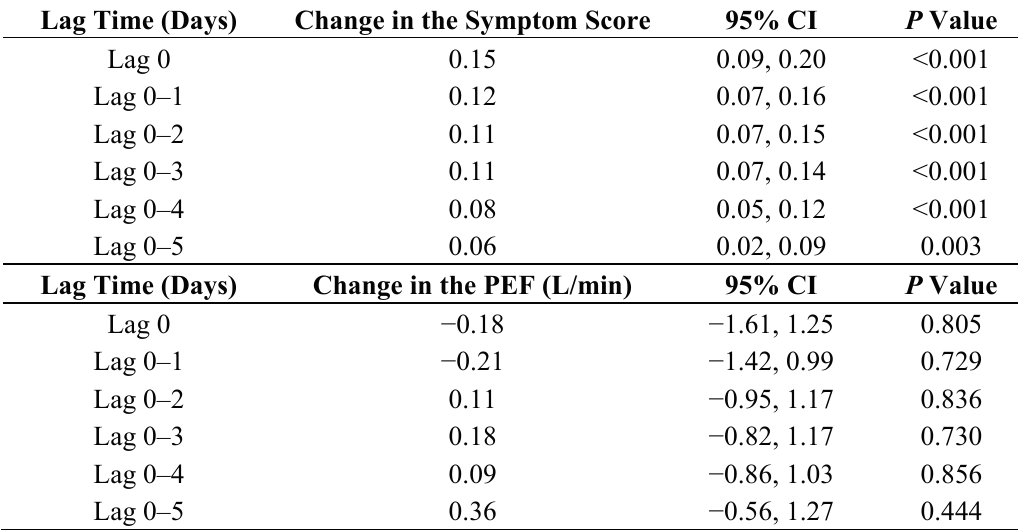
Table 3. Association of heavy dust exposure with the change in lower respiratory tract symptoms and the